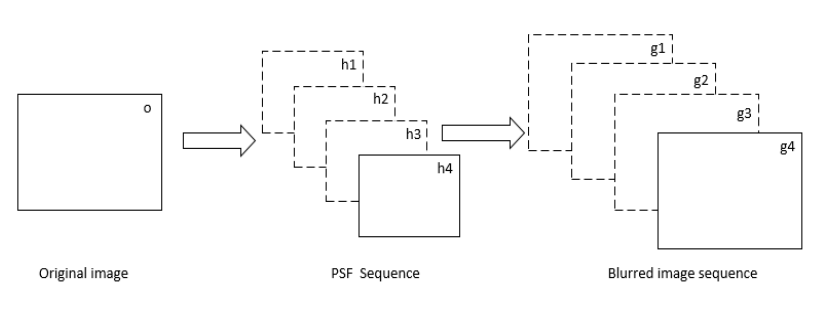
Figure 2. Image degradation under short exposure